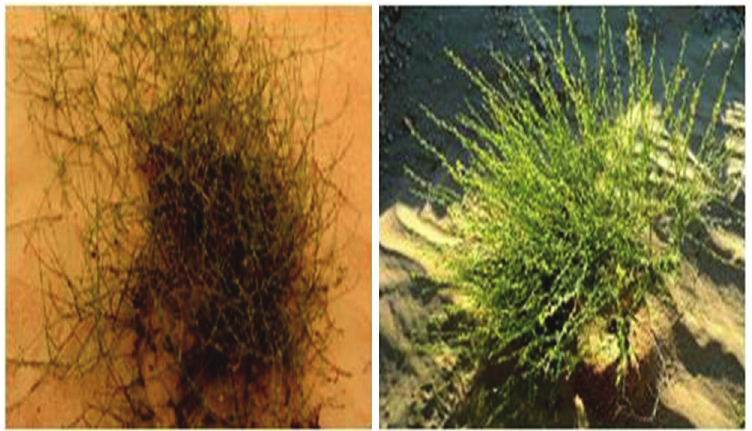
Figure 1 - Dipterygium glaucum plants grown widely in Saudi Arabia desert. (See the colors in the online